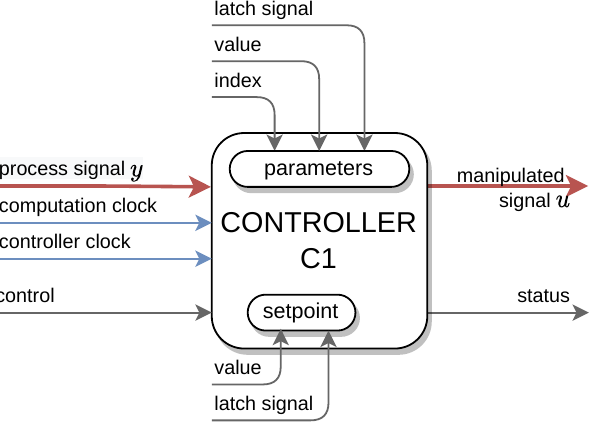
Figure 10. General controller structure as it is implemented in the considered